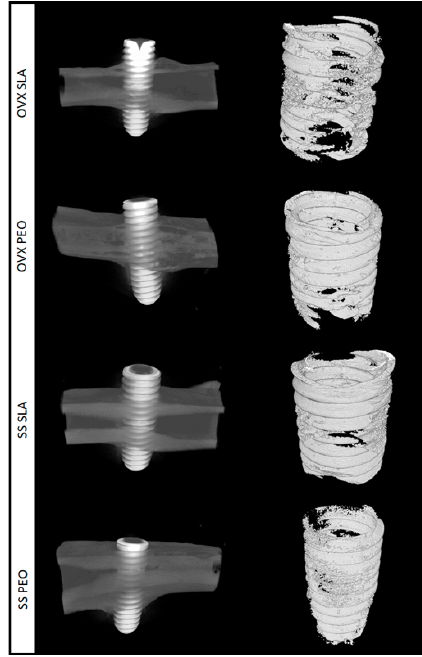
Figure 3. Representative microtomography sections for SLA and PEO surface coating in groups SS and OVX at 60 days. Left side (3D reconstruction); Right side (ROI extracted from computed microtomography reconstruction).